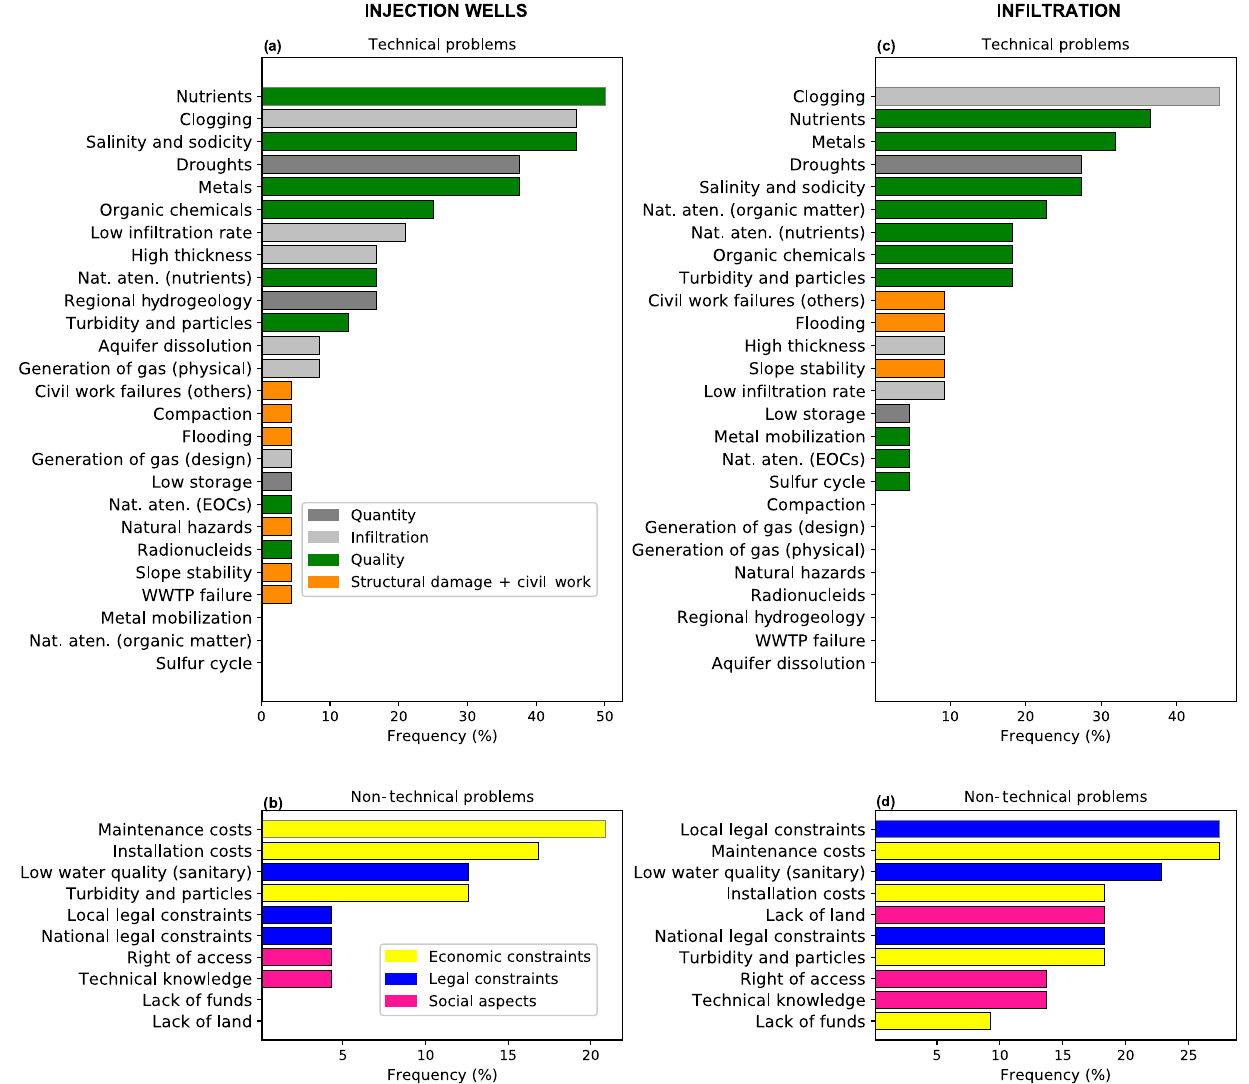
Figure 1. Sorted list in terms of frequency of appearance of the main problems observed in reviewed facilities of deep well injection and infiltration basin. Problems are classified into categories (four for technical, three for non-technical) that are visualized as